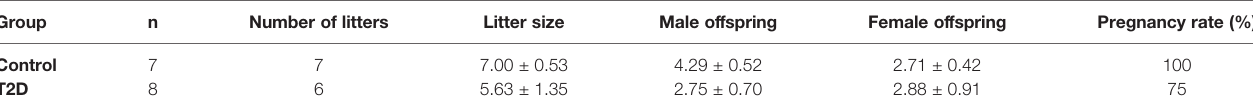
TABLE 1 | Reproductive effects of T2D in males (parental generation, P).